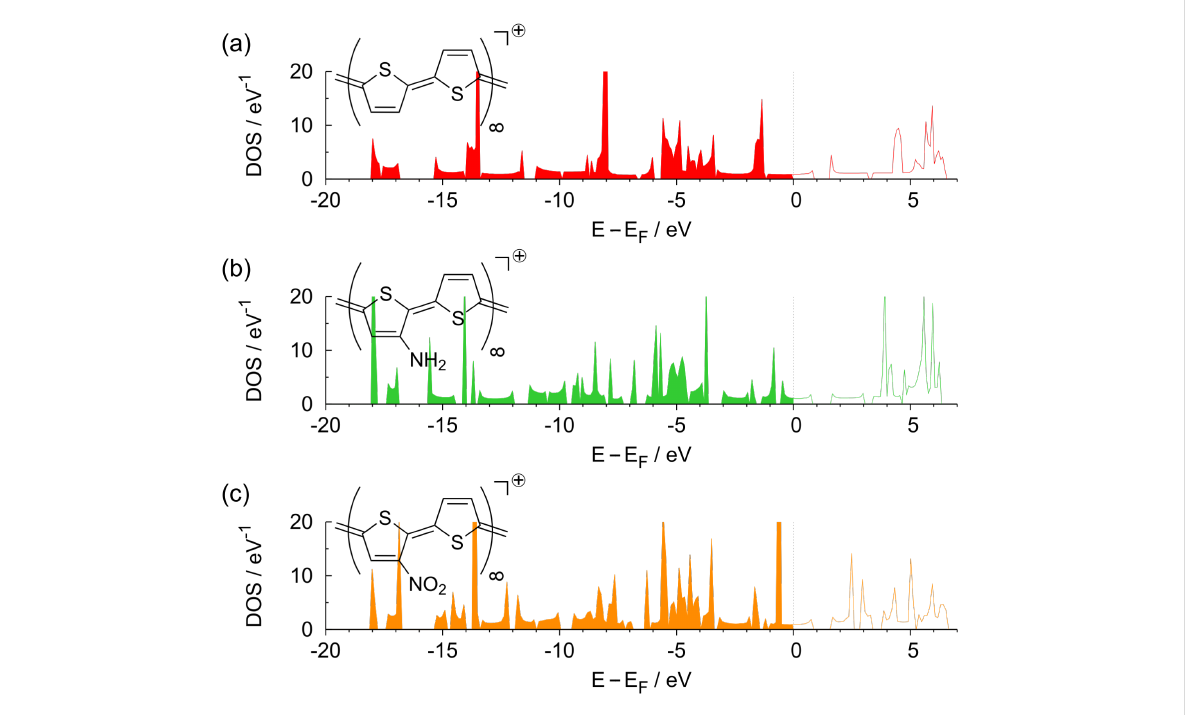
Phenyl-substituted polythiophenes as well as vinyl-bridged polythiophene-derivatives, on the other hand, have drastically modified band gaps. In addition, positively charged polythio- phenes were considered as a model for doped polythiophenes. All considered charged polythiophenes become metallic, which shows that the modified band gaps cannot be explained by simple electron removal or addition. However, the unit cell in the periodic DFT calculations was still too small to allow for the formation of